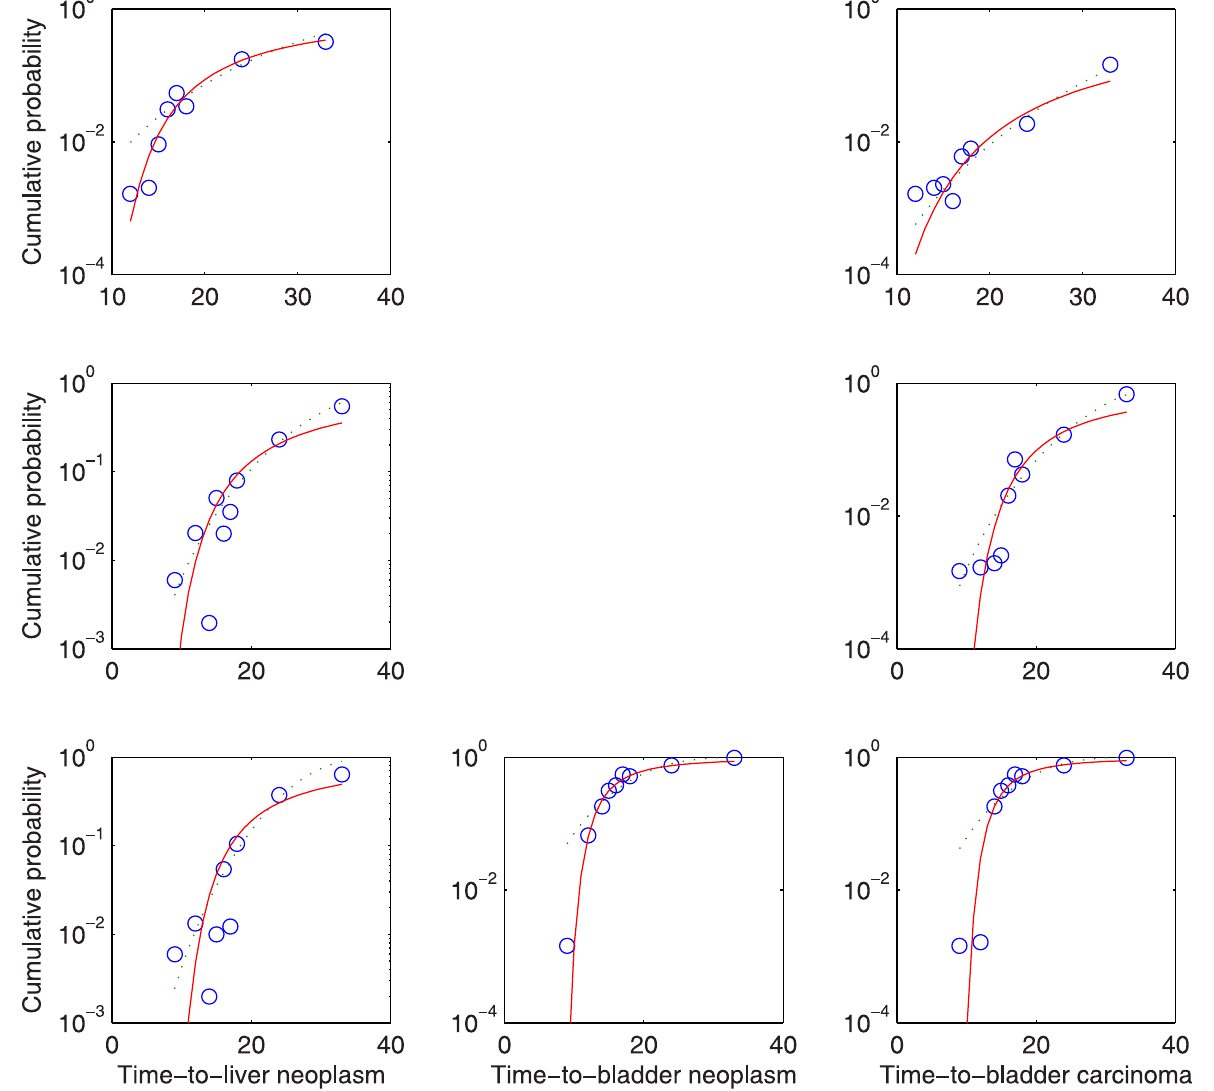
Fig 8. Empirical distributions (o) of ED 01 study data on bladder neoplasms, liver neoplasms, and bladder carcinomas resulting from continuous exposure to the carcinogen 2-acetylaminofluoren, and fitted Weibull ( — ) and first-order time-transform ( − ) distributions. Columns 1 – 3: liver neoplasms, bladder neoplasms, and bladder carcinomas, respectively; Rows 1 – 3: 75, 100, and 150 ppm, respectively. Bladder neoplasm and bladder carcinoma data are identical at 75 and 100 ppm (all neoplasms malignant), therefore not shown again.